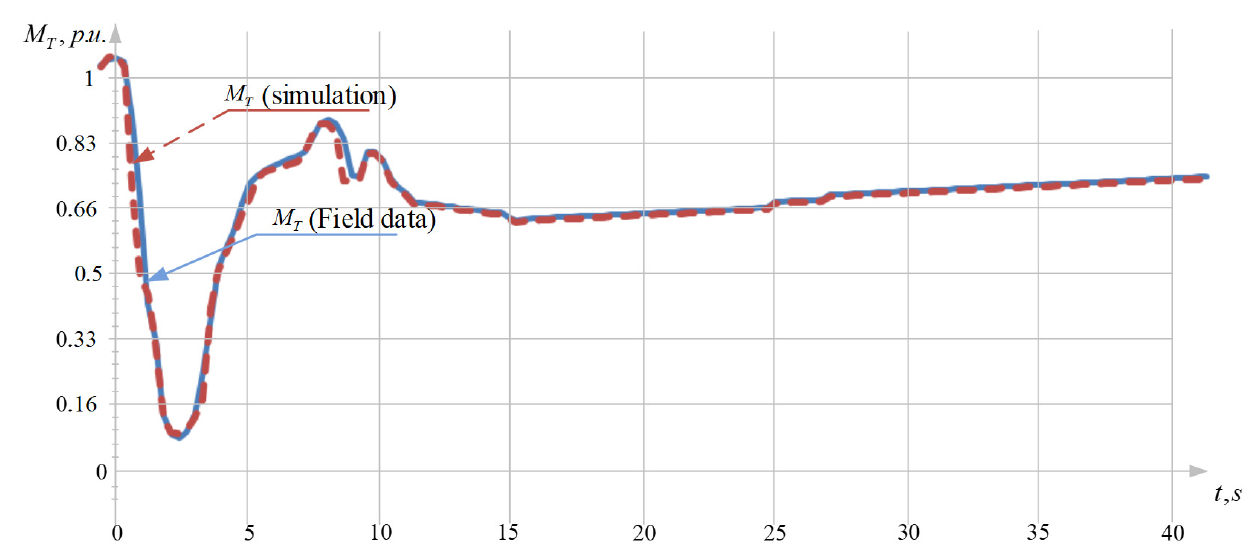
Figure 9. Graphs of turbine torque changes during FV .